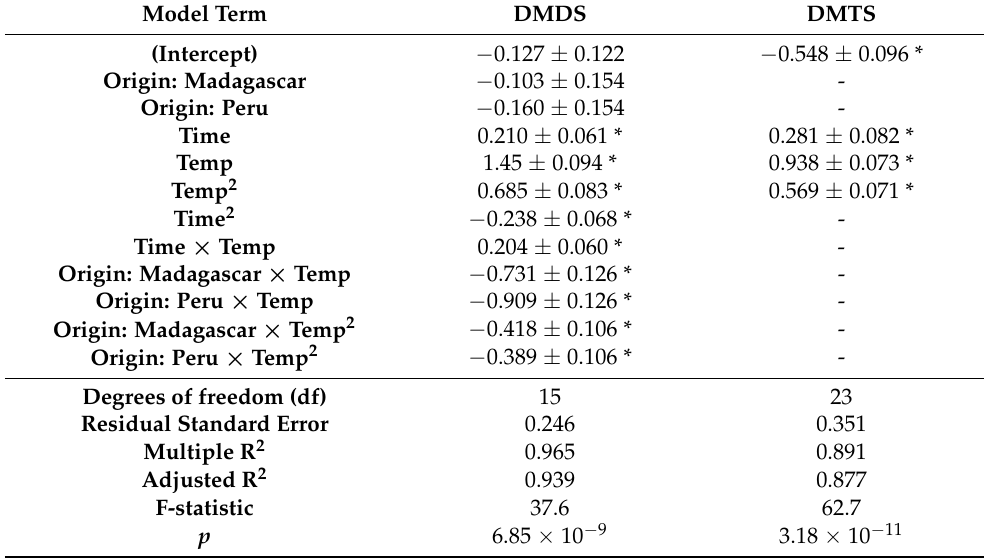
Table 2. Model coefficients ± standard errors for the dimethyl disulfide (DMDS) and dimethyl trisulfide (DMTS) regression models. Coefficient estimates show changes in relative concentration. Significant model terms ( p < 0.05) are indicated by an asterix